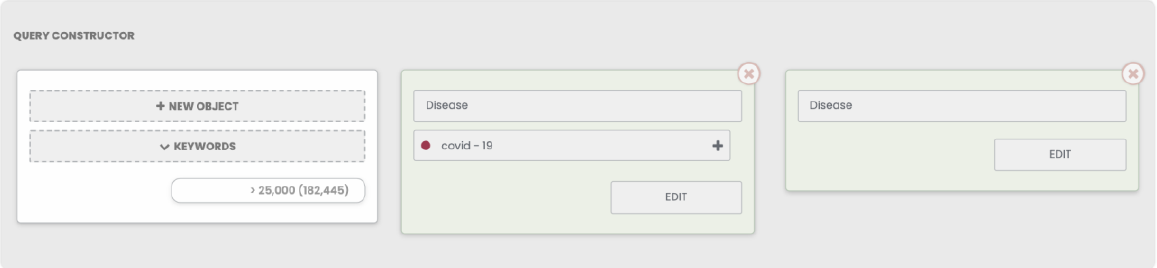
Figure 5. The search query used to find PubMed documents containing COVID-19 and mentioning at least one other disease with ANDDigest ver. 01.2022.